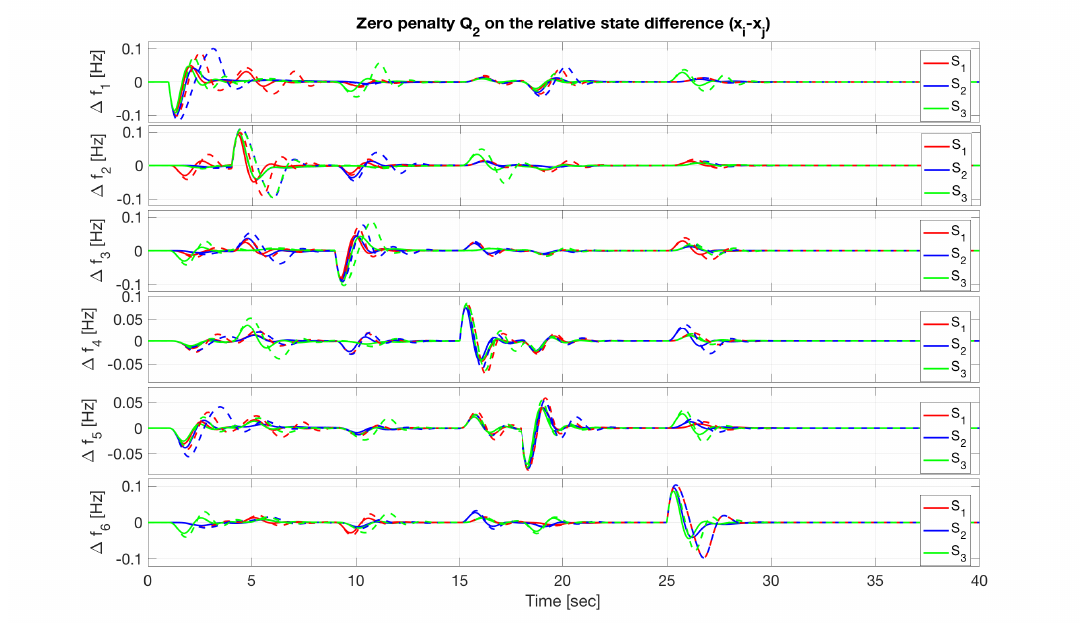
Figure 9. Frequency transients of the six-area power system for three tie-line interconnection schemes ( S ) . Zero penalty on the relative state-difference between interconnected areas. Solid lines 1 , S 2 , S 3 depict transients of the linear model; dashed lines depict transients of the model with saturator (Figure 8).